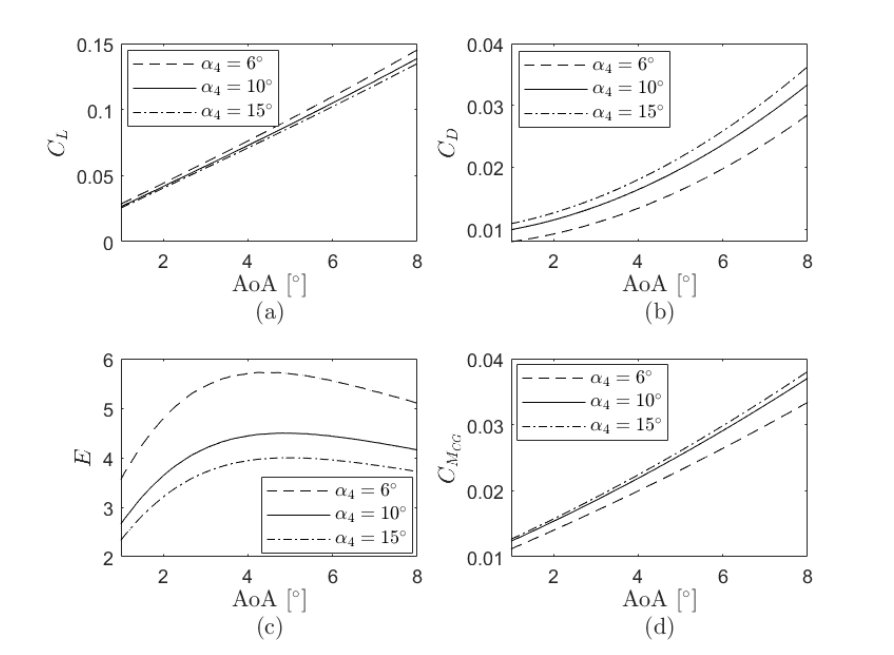
Figure 9. Variations of the aerodynamic parameters due to the modifications in α 4 , ( a ) C L vs. AoA